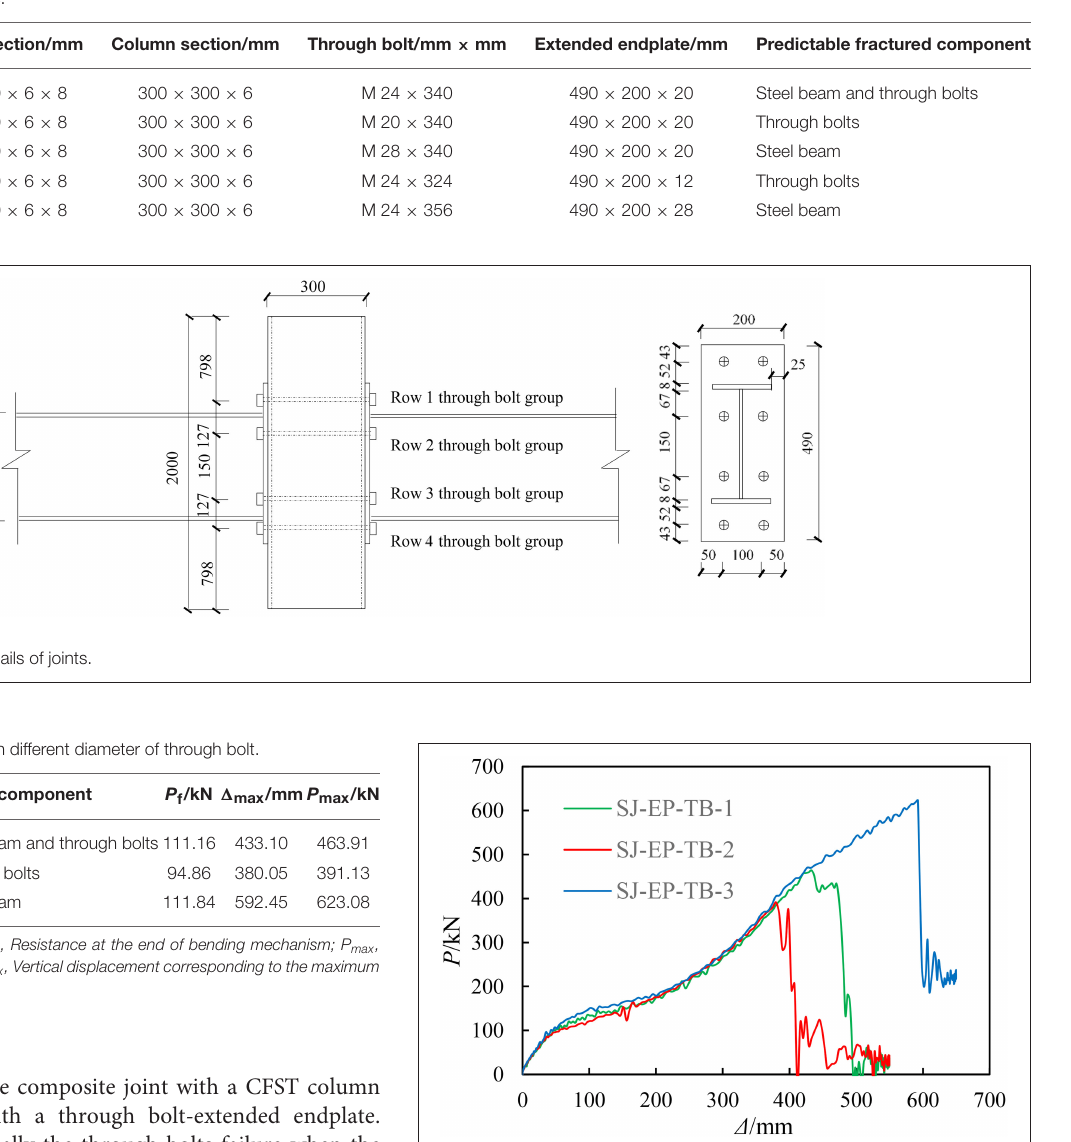
FIGURE 9 | Resistance curves comparison with a different diameter of the through bolt.